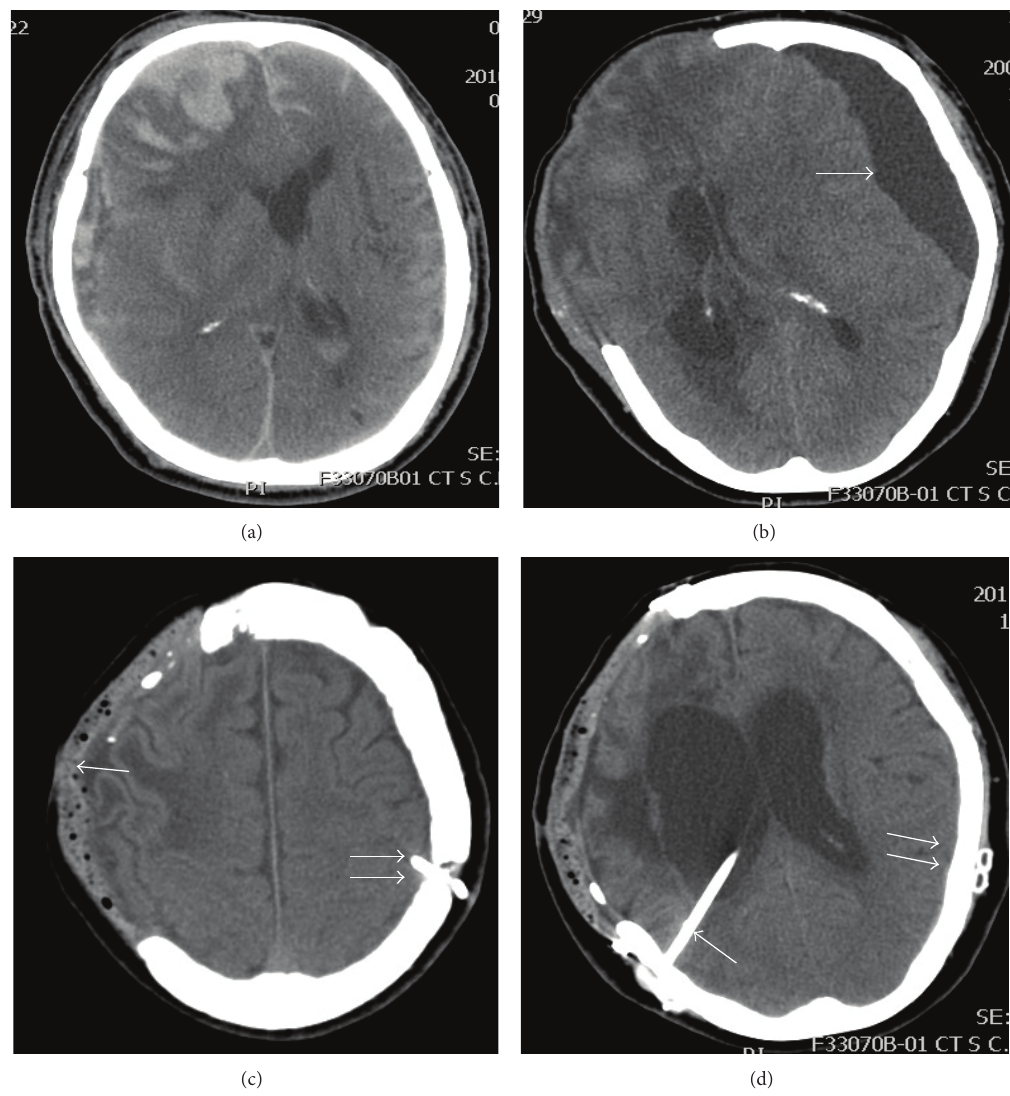
Figure 1: Representative pre- and postoperative CT images of case 1. (a) CT scan of case 1, revealing acute subdural hematoma, contusion hemorrhage, and subarachnoid hemorrhage in the right frontotemporal region, with significant mass effect. Wide craniectomy with the removal of hematoma was indicated. (b) A later follow-up CT scan revealed SDG contralateral to DC (arrow), with significant mass effect. (c) Simultaneous cranioplasty (single arrow) and contralateral SP shunting (double arrow) were performed and postoperative CT scan revealed completely resolved SDG and reversed midline shift. (d) A later follow-up CT scan revealed hydrocephalus and VP shunt (single arrow) following SP shunt (double arrow) insertion earlier to eliminate both hydrocephalus and contralateral SDG,